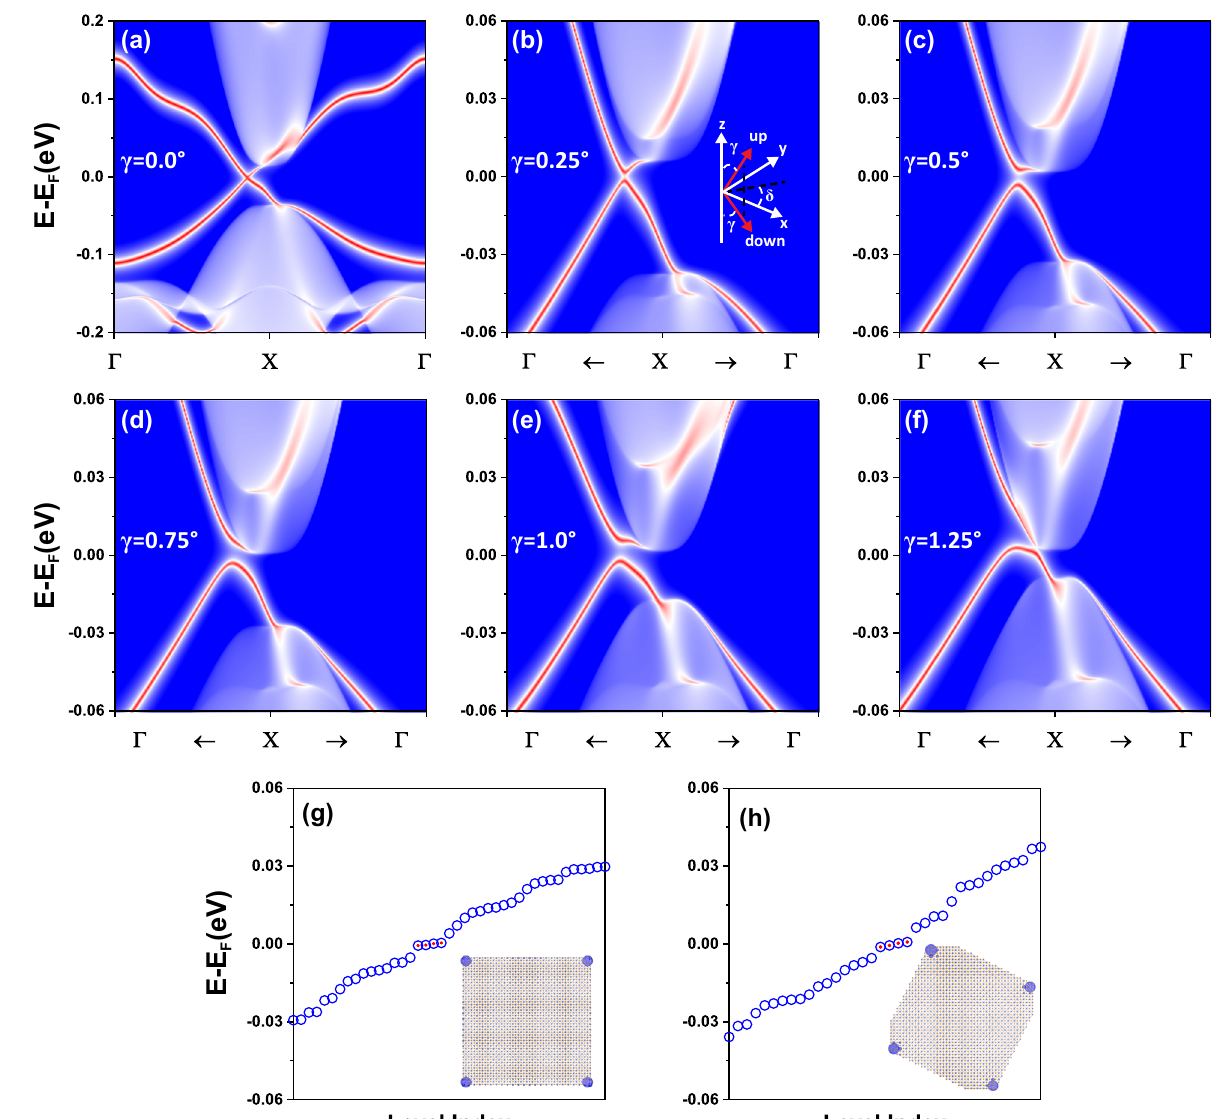
Fig. 3 Robust topological edge and corner states. a The gapless QSH edge state along ferromagnetic edge of monolayer FeSe with checkerboard AFM order. b – f Zoom-in gapped topological edge state by canting the spin direction with δ = 45°, ( b ) γ = 0.25°, ( c ) γ = 0.5°, ( d ) γ = 0.75°, ( e ) γ = 1.0° and ( f ) γ = 1.25°. The canted spin-up and -down (red arrows) directions are determined by angle γ and δ , as shown schematically in inset of ( b ). g Discrete energy levels of rectangular monolayer FeSe cluster with four naturally cleaved ferromagnetic edges of the same spin (see also Fig. 1e). The four in-gap topological corner states are marked in red-dot around the Fermi-level. The inset is spatial charge density distribution of the corner states. The radii of circle on each atom denotes the absolute value of charge density. h is the same as ( g ), but for a rotated rectangular cluster with non-naturally cleaved ferromagnetic edges of the same